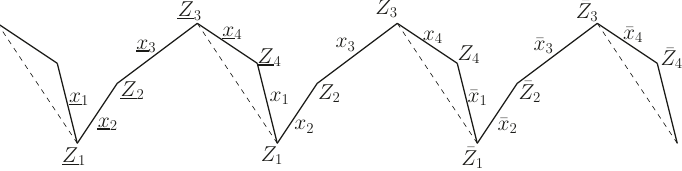
Figure 3. Dual periodic Wilson line configuration for the four-point form factor in momentum twistor